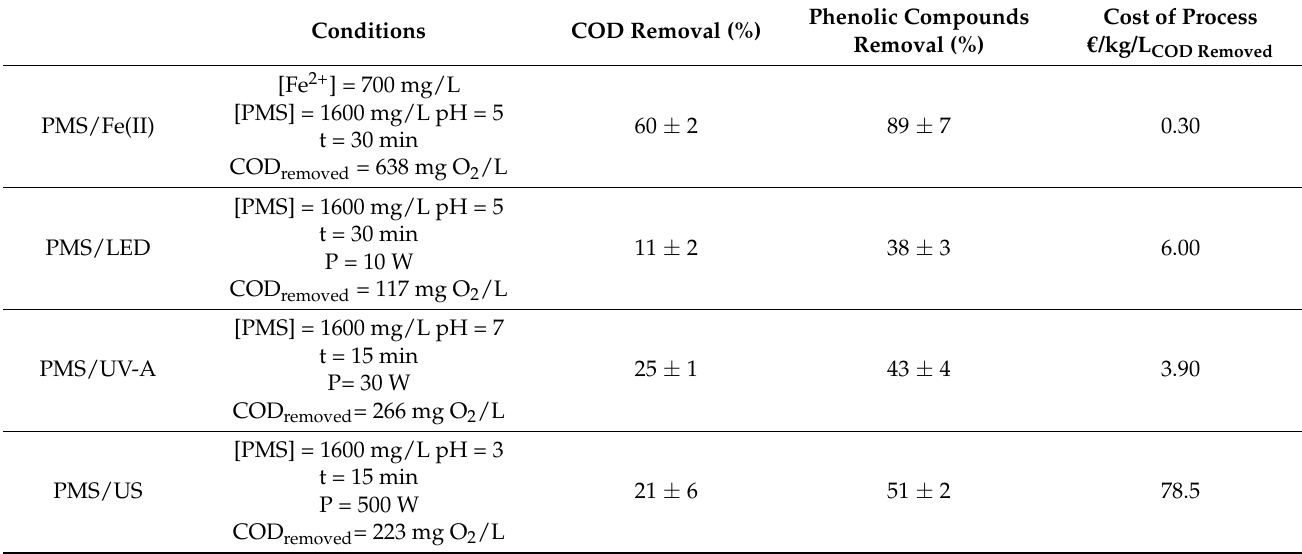
Table 4. Different ways for PMS activation and associated operating costs.